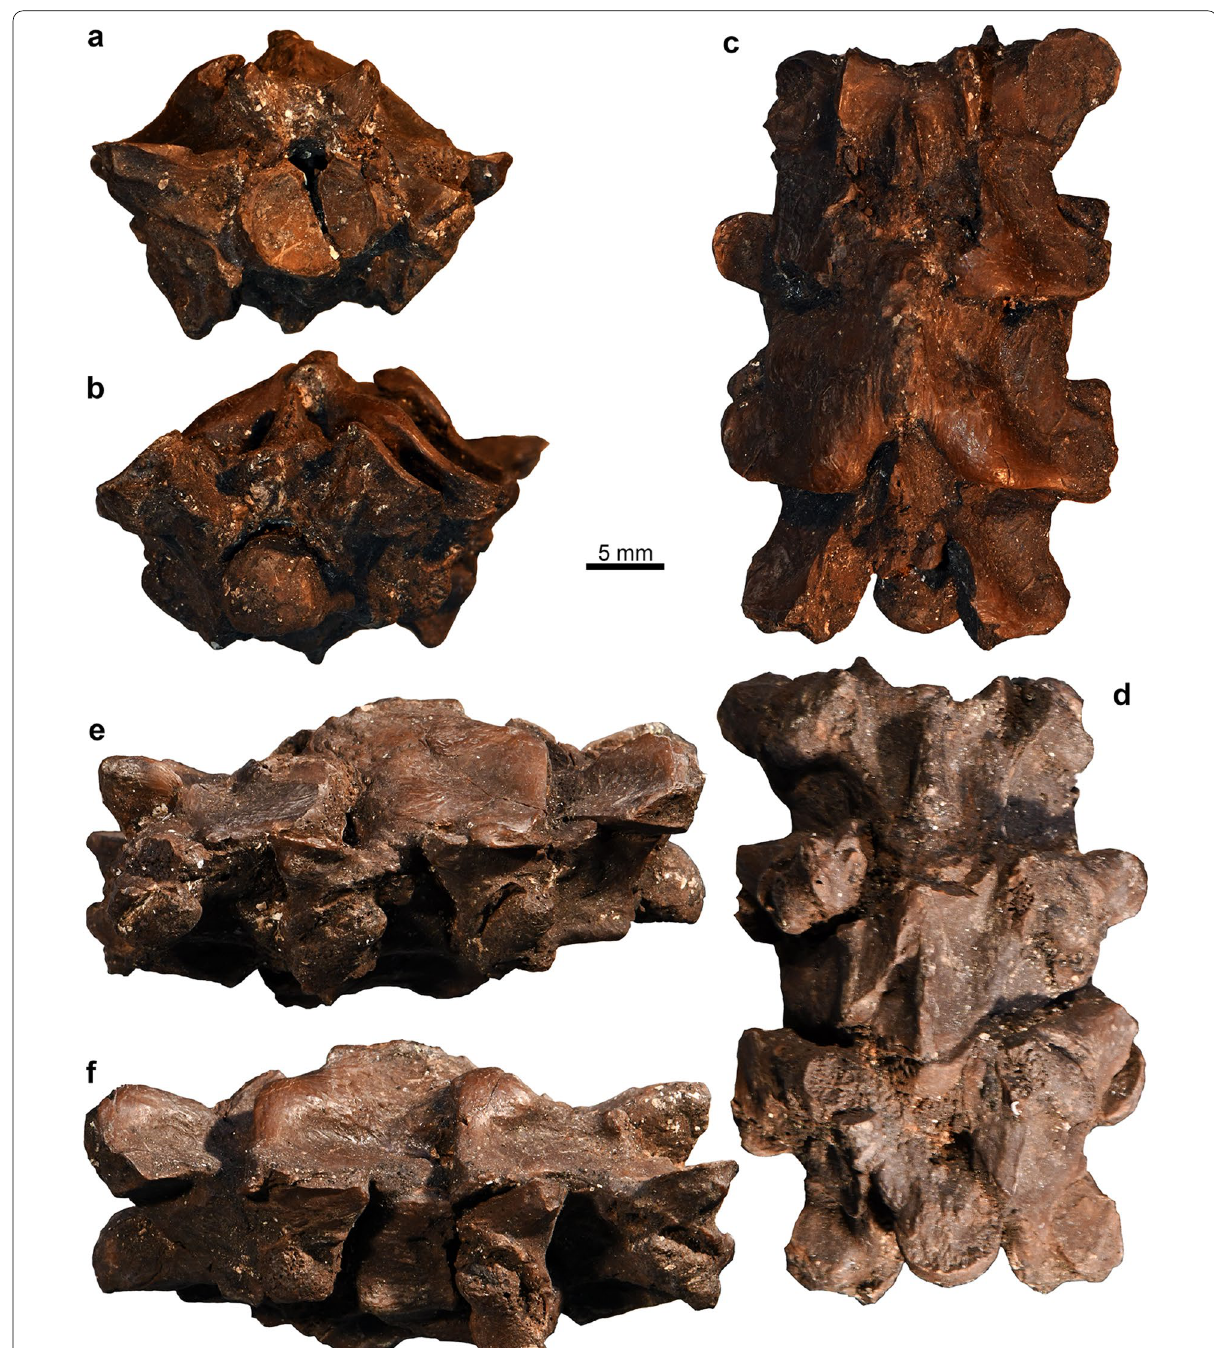
Fig. 31 Palaeopython ceciliensis from unknown quarry, Geiseltal: three articulated posterior trunk vertebrae (GMH Y-38a) in anterior ( a ), posterior ( b ), dorsal ( c ), ventral ( d ), left lateral ( e ), and right lateral ( f )